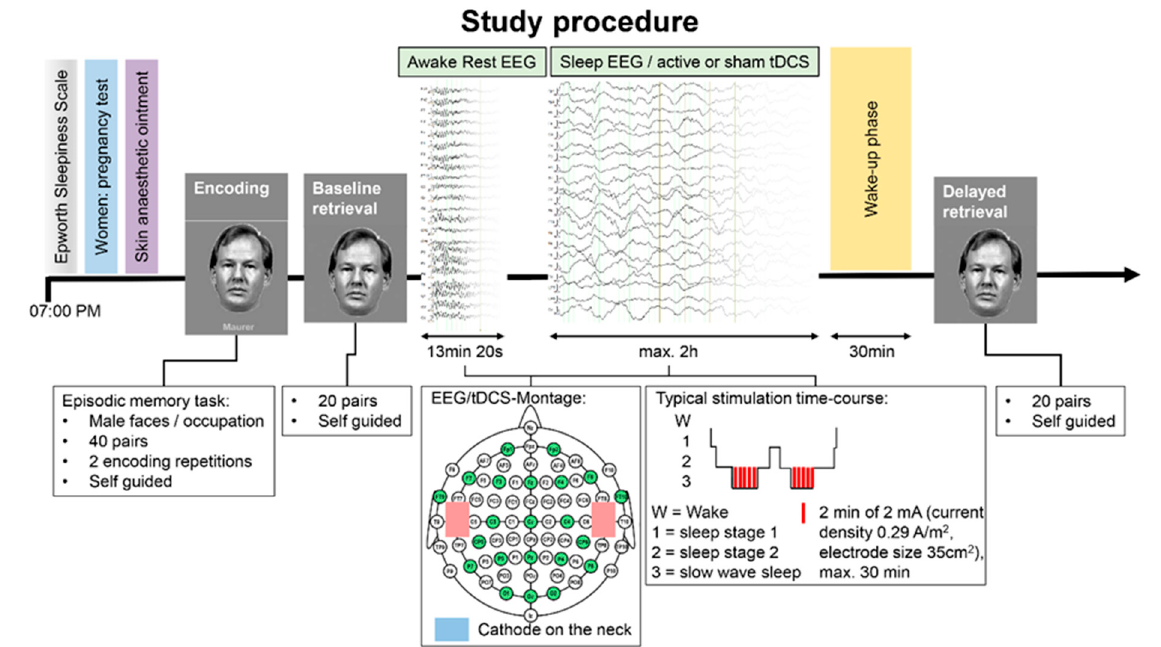
Figure 3. Participants underwent this study procedure twice with at least four weeks in between sessions, once with active tDCS and once with sham stimulation. Red rectangles represent anodal tDCS electrodes; the blue rectangle represents the cathodal tDCS electrode. Green shaded circles represent the 22 recording EEG channels overlaid on the 10–20 international electrode system (Fp1, Fp2, F7, F3, Fz, F4, F8, FT9, FT10, C3, Cz, C4, CP5, CP6, P7, P3, Pz, P4, P8, O1, Oz, O2).